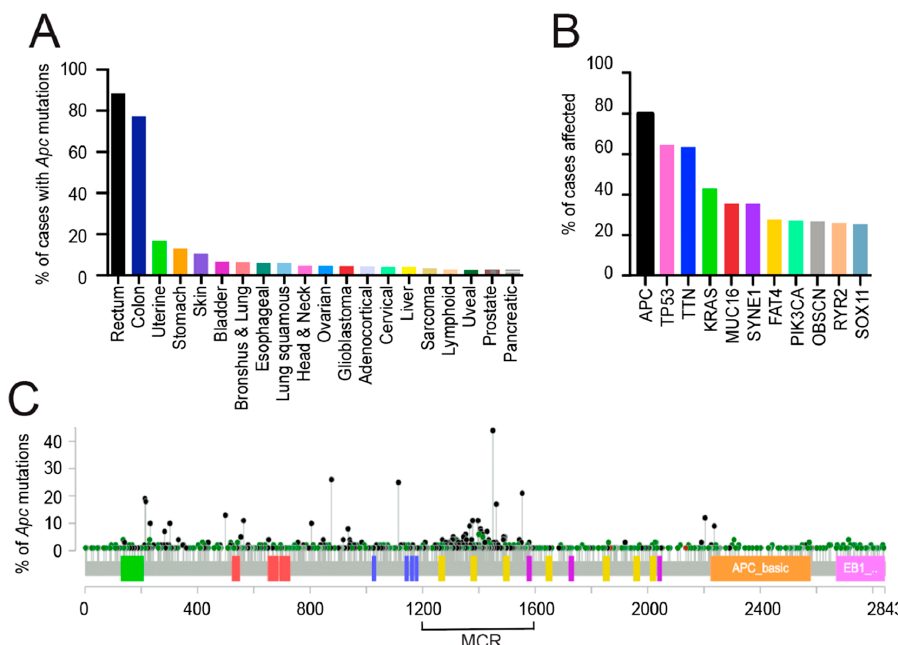
Figure 2. Frequency of Apc mutations based on ‘The Cancer Genome Atlas Project’ (TCGA) from the National Cancer Institute Genomic Data Commons and the cBioportal databases [131–133]. ( A ) Percentage of cases with Apc mutations found across the different cancer projects. The primary sites with most Apc mutations are the rectum (black bar) and the colon (blue bar), as retrieved from the National Cancer Institute Genomic Data Commons database. ( B ) Mutation frequency of the indicated genes derived from the TCGA—Rectum and Colon projects. ( C ) Lollipop plot showing Apc mutations annotated in TCGA from the cBioPortal database. Green circles represent missense mutations (471 in total) and black circles represent truncating mutations (751 in total). The mutated cluster region (MCR), where most of the Apc mutations occur, encodes the region spanning amino acid position 1284 to the 1580. The most frequent mutations introduce a stop codon at amino acid position 1450 (AA change to R1450* (stop)). Colour code boxes indicate various domains in APC (see text).